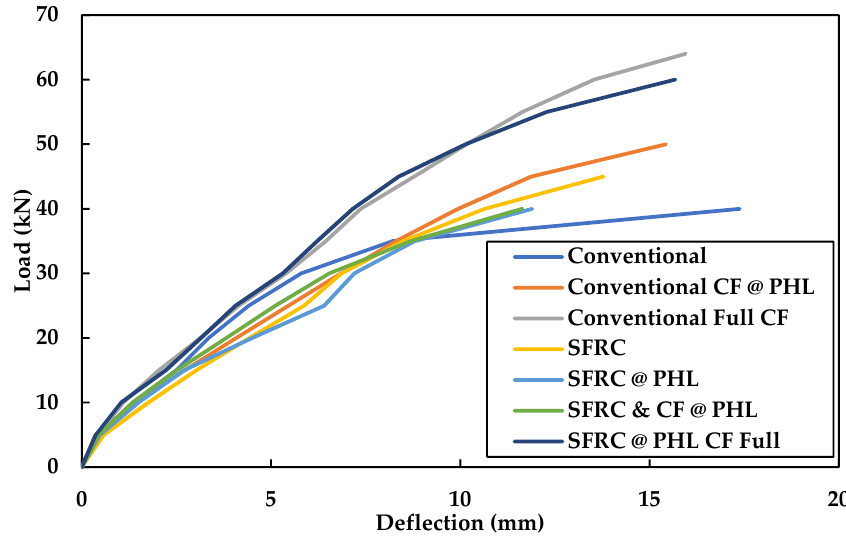
Figure 13. Load-deflection graphs from experiments.